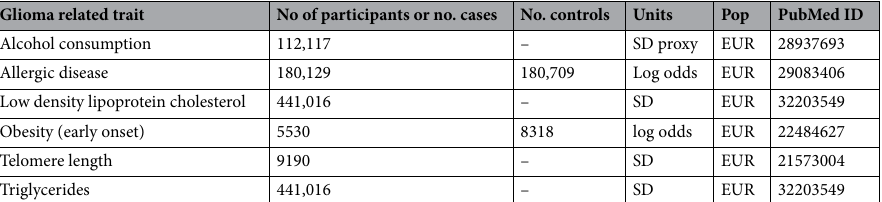
Table 9. The glioma related trait used an outcome in the MR analysis. SD standard deviation, Pop population of the study participants.